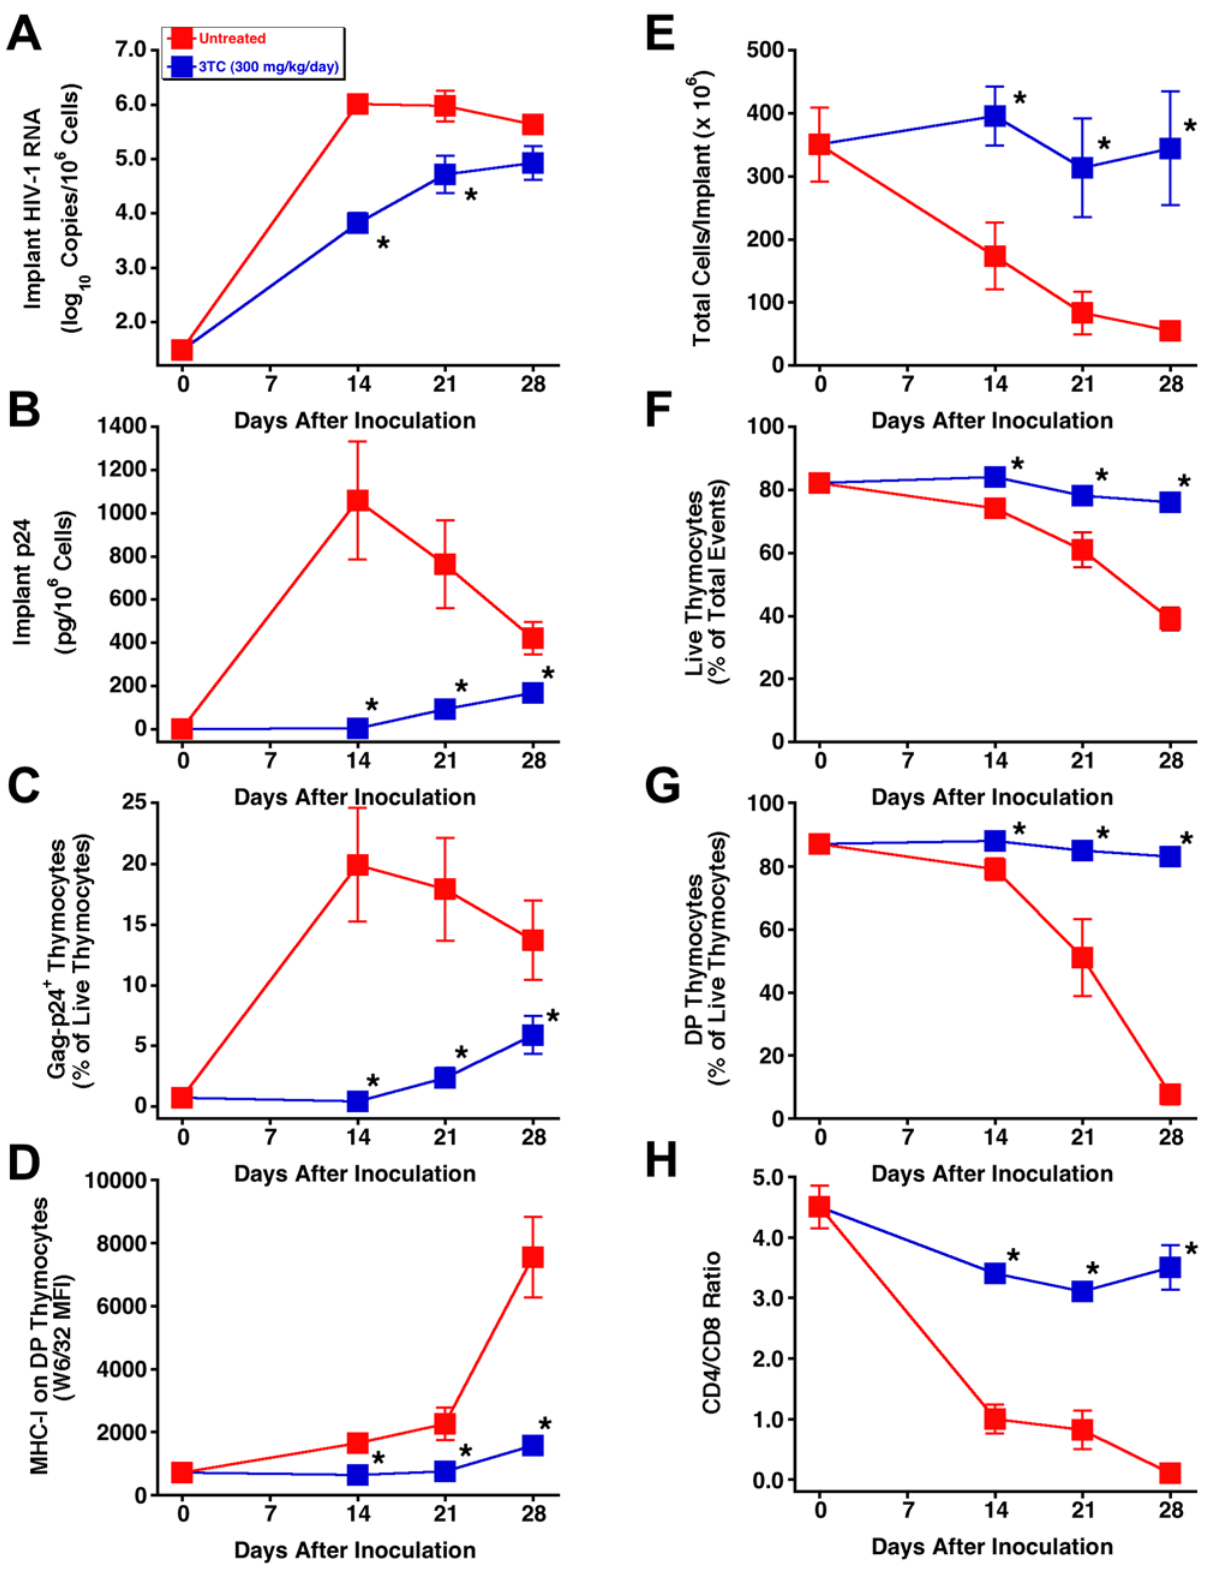
Figure 2. 3TC treatment of HIV-1 JD-infected SCID-hu Thy/Liv mice inhibits viral replication and protects implants from virus-mediated thymocyte depletion. Mice were treated by twice-daily oral gavage with 3TC at 300 mg/kg per day beginning on day + 1 after inoculation, and Thy/ Liv implants were collected 14, 21, and 28 days after inoculation. Antiviral efficacy was assessed by determining HIV-1 RNA (A), p24 (B), Gag-p24 + thymocytes (C), and MHC-I expression on DP thymocytes (D). Thymocyte protection was assessed by total implant cellularity (E), thymocyte viability (F), percentage of DP thymocytes (G), and CD4/CD8 ratio (H) for 3TC-treated mice versus untreated mice (means 6 SEM). *p # 0.05, compared with untreated mice for 5–7 mice per group. doi:10.1371/journal.pone.0000655.g002 PLoS ONE |